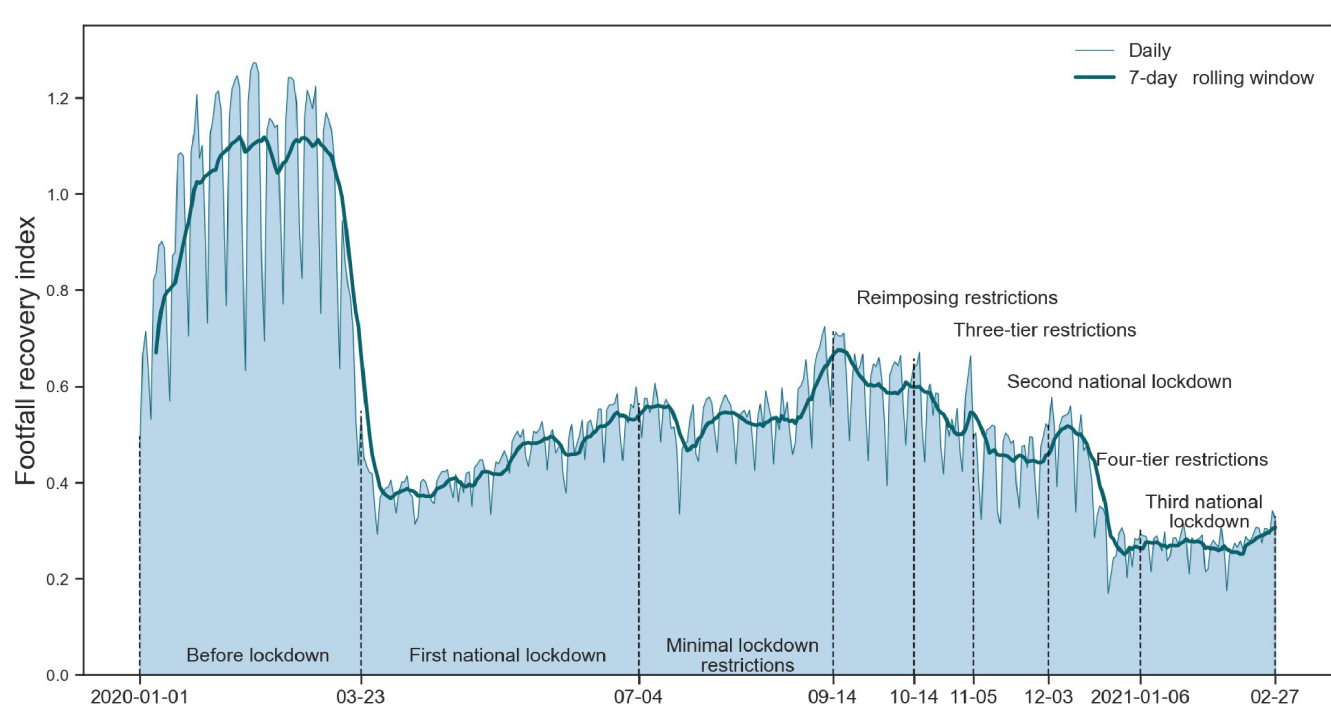
Fig 3. Daily footfall recovery index in Greater London from 2020-01-01 to 2021-02-07. Daily and 7-day rolling window observations are shown as light blue and dark blue lines, respectively. The eight policy restriction phases are distinctively separated by vertical lines labelled with the start/end date.